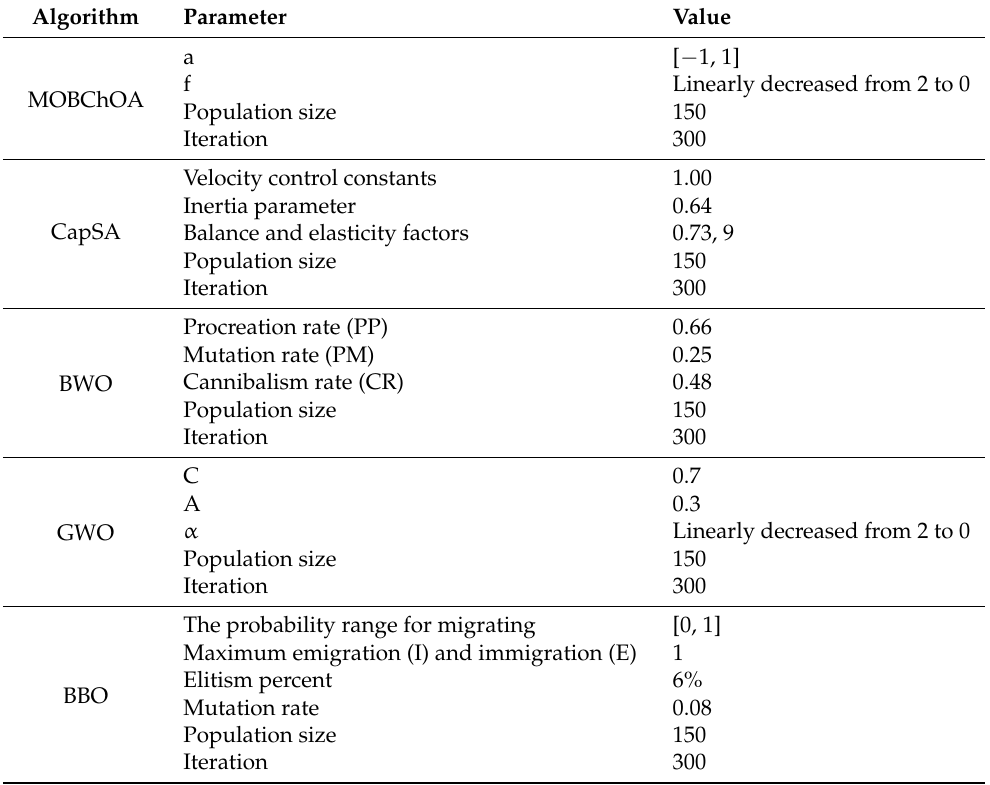
Table 3. The optimal parameter settings of the algorithms.